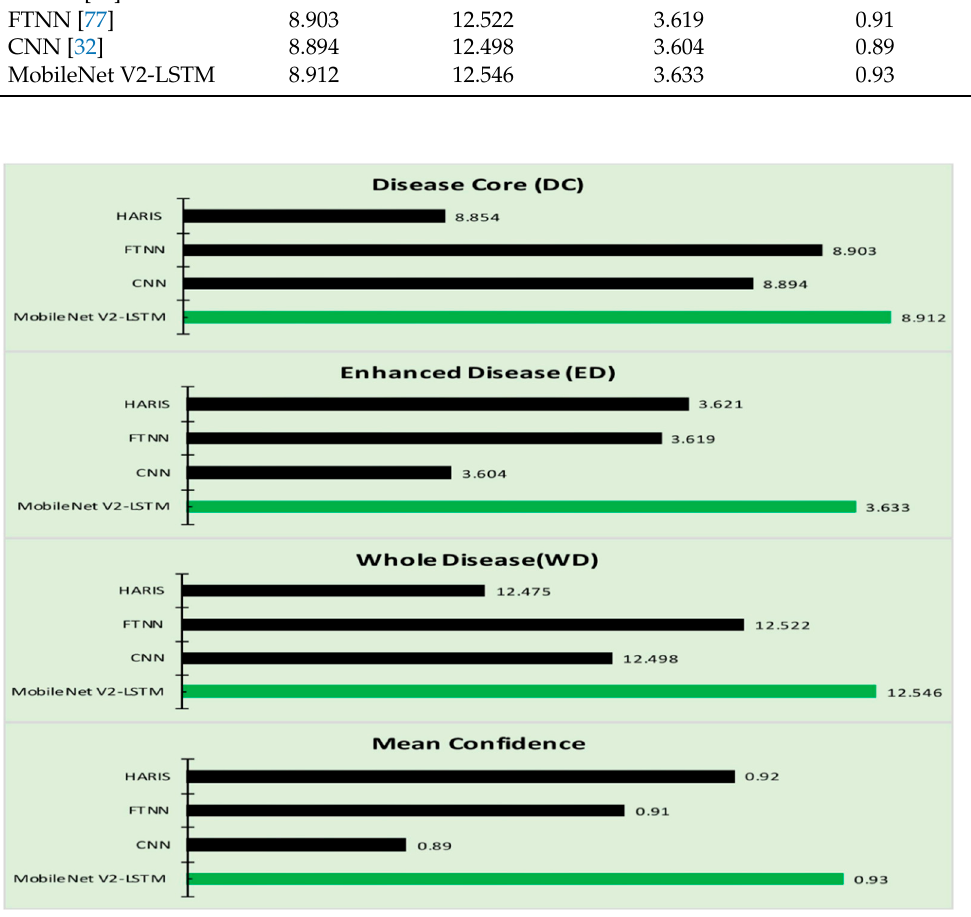
Figure 12. The hyperparameters of the proposed model.